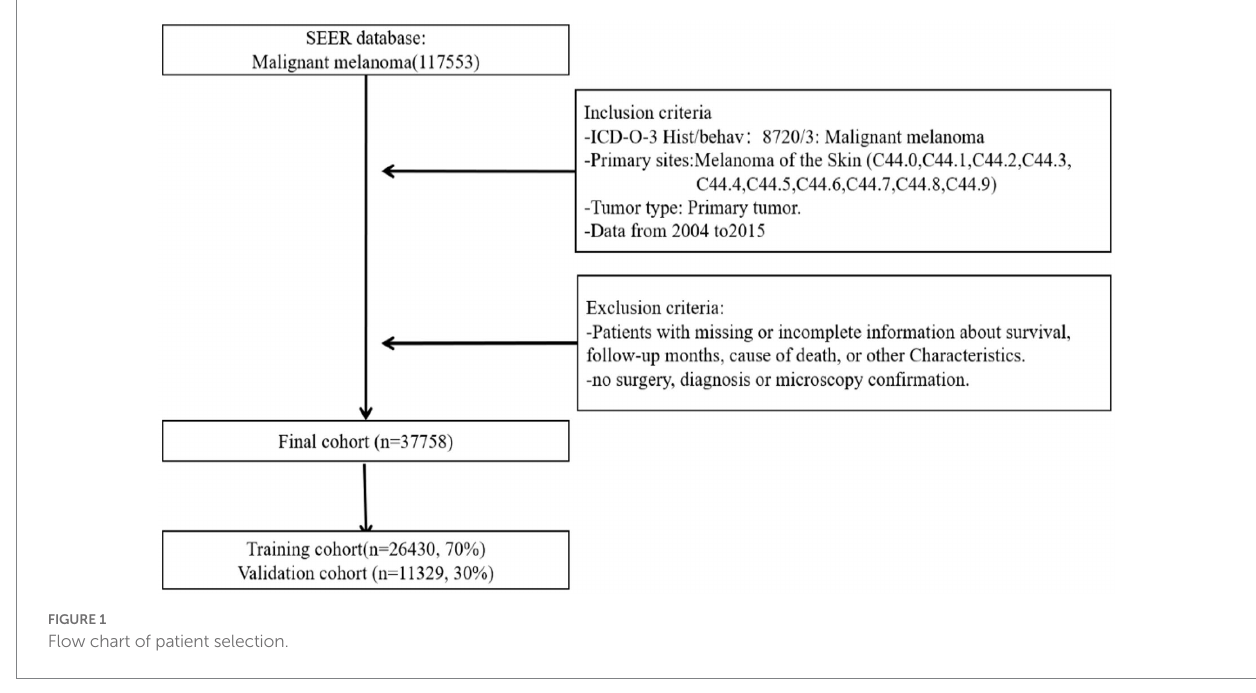
FIGURE 1 Flow chart of patient selection.